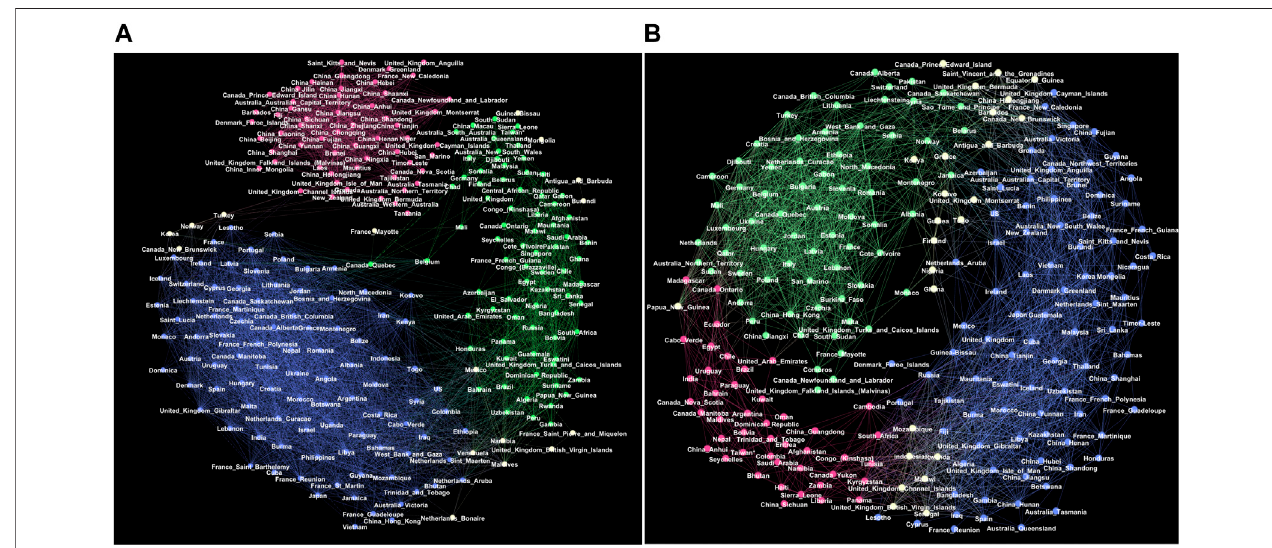
FIGURE 3 | Giant connected components of the correlation networks at the threshold θ =0.5 for the outbreak period (A) and the immunisation period (B) . Red, green and blue colours indicate groups of nodes in three respective communities G1, G2, G3 in the outbreak network, and g1, g2, g3 in the immunisation period network, determined by the eigenvector-localisation, see text and Figure 4 . Unclassi fi ed borderline nodes are shown in white colour. Labels on nodes identify the corresponding country or province. The complete lists of nodes in each community are given in Supplementary Tables S1 – S6 in Supplementary Information.